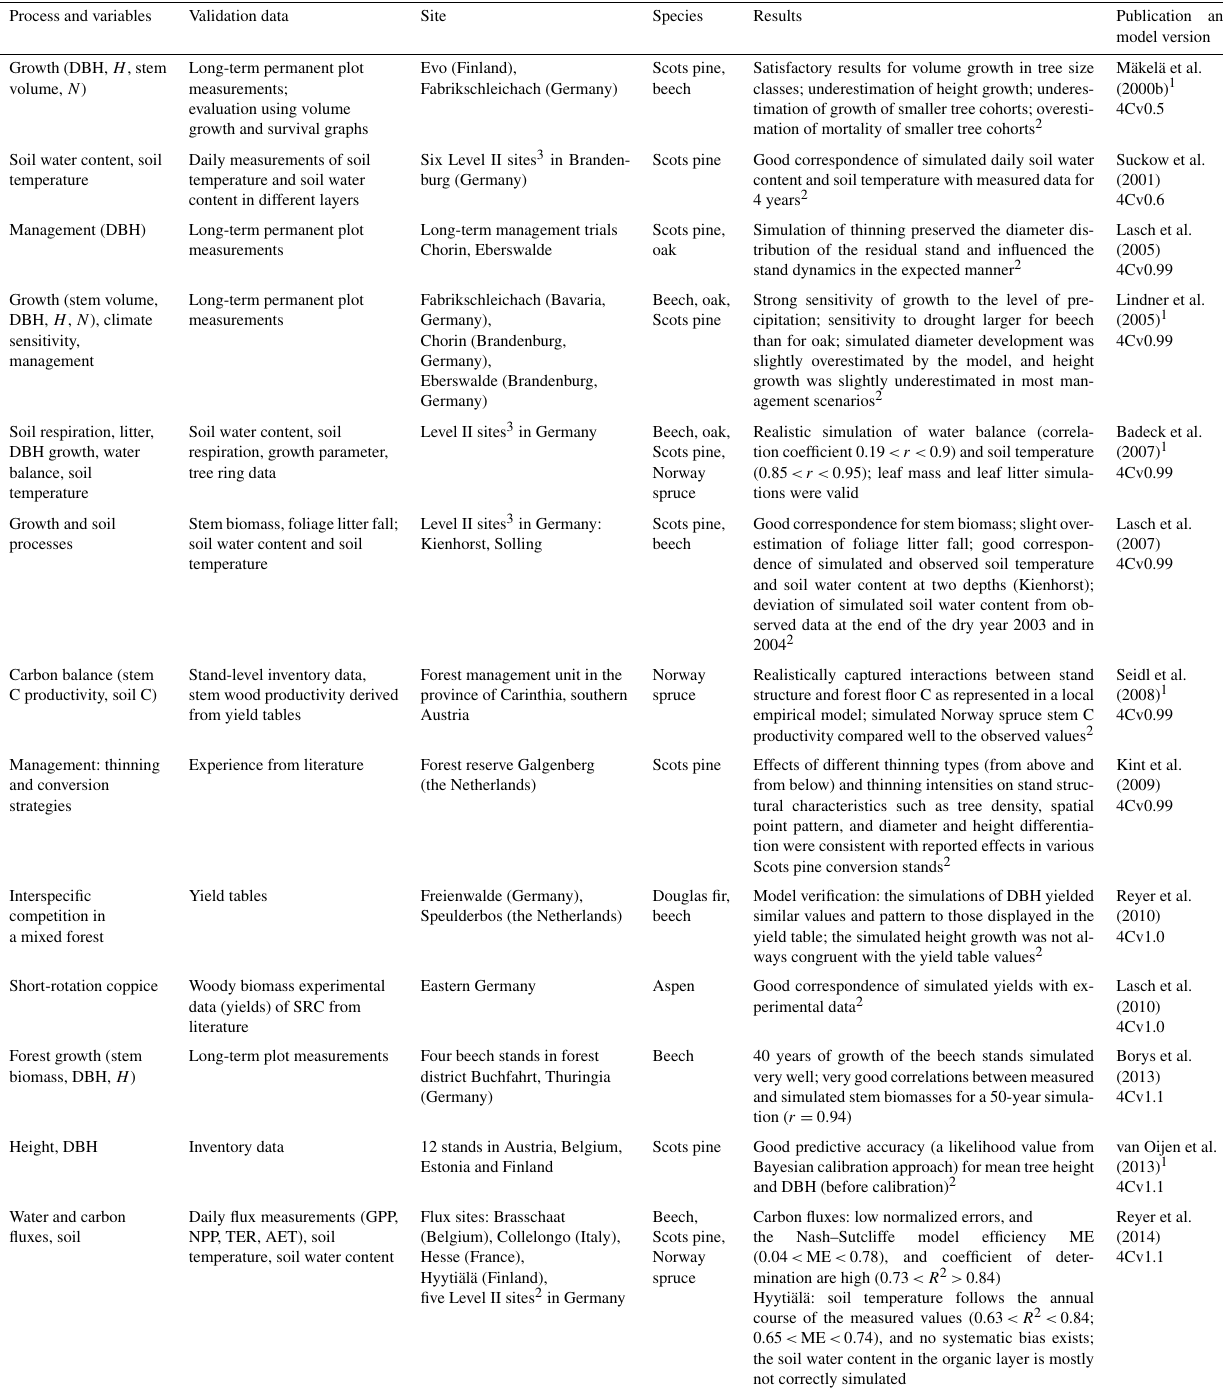
Table 1. Overview of studies in which different species, processes, and variables of 4C were evaluated (DBH – diameter at breast height, H – height, N – stem number, AET – actual evapotranspiration, NPP – net primary production, NEE – net ecosystem exchange, TER – total ecosystem respiration, GPP – gross primary